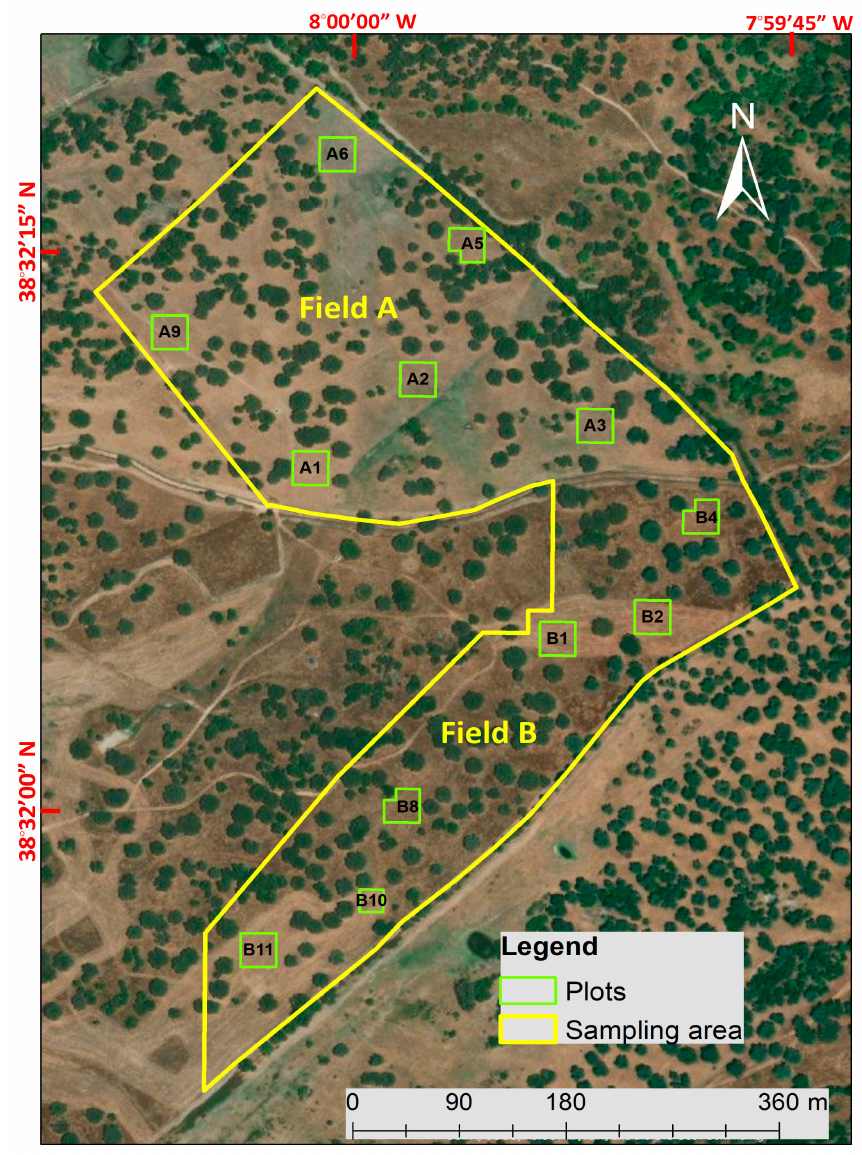
Figure 1. Experimental fields (A and B) and respective sampling